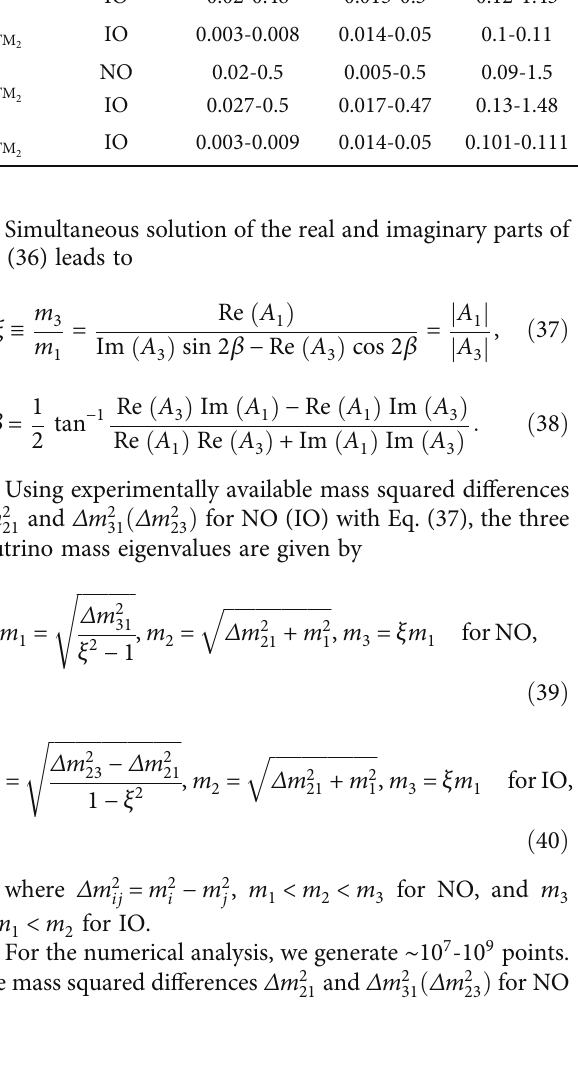
≡ Δ m 2 = − Δ m 2 < 0 for IO. 32 23 3 l